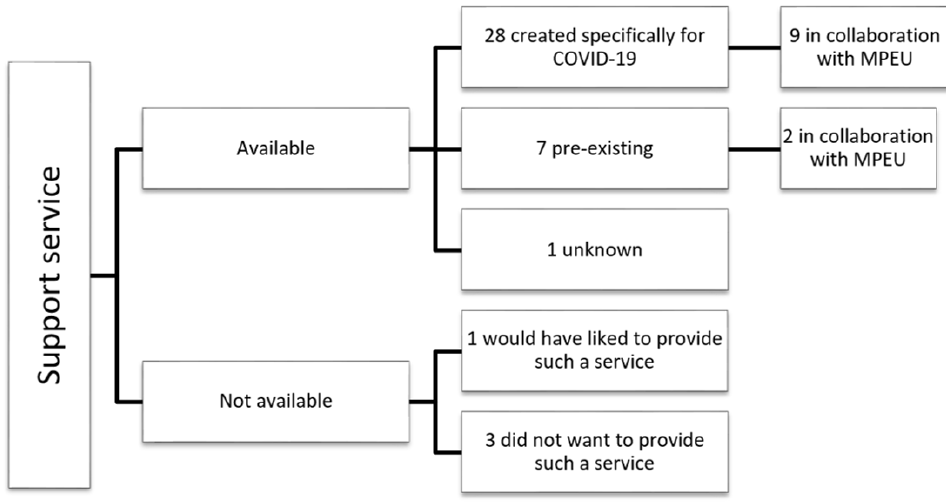
Figure 1. Details of the mental health support services in place during the first wave of the COVID-19 epidemic in France, according to study respondents. MPEU, medico-psychological emergency unit.